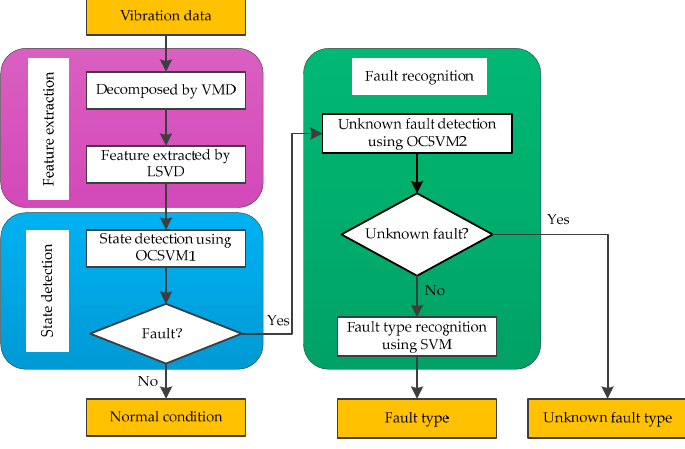
Figure 2. Fault diagnosis process of the proposed method.